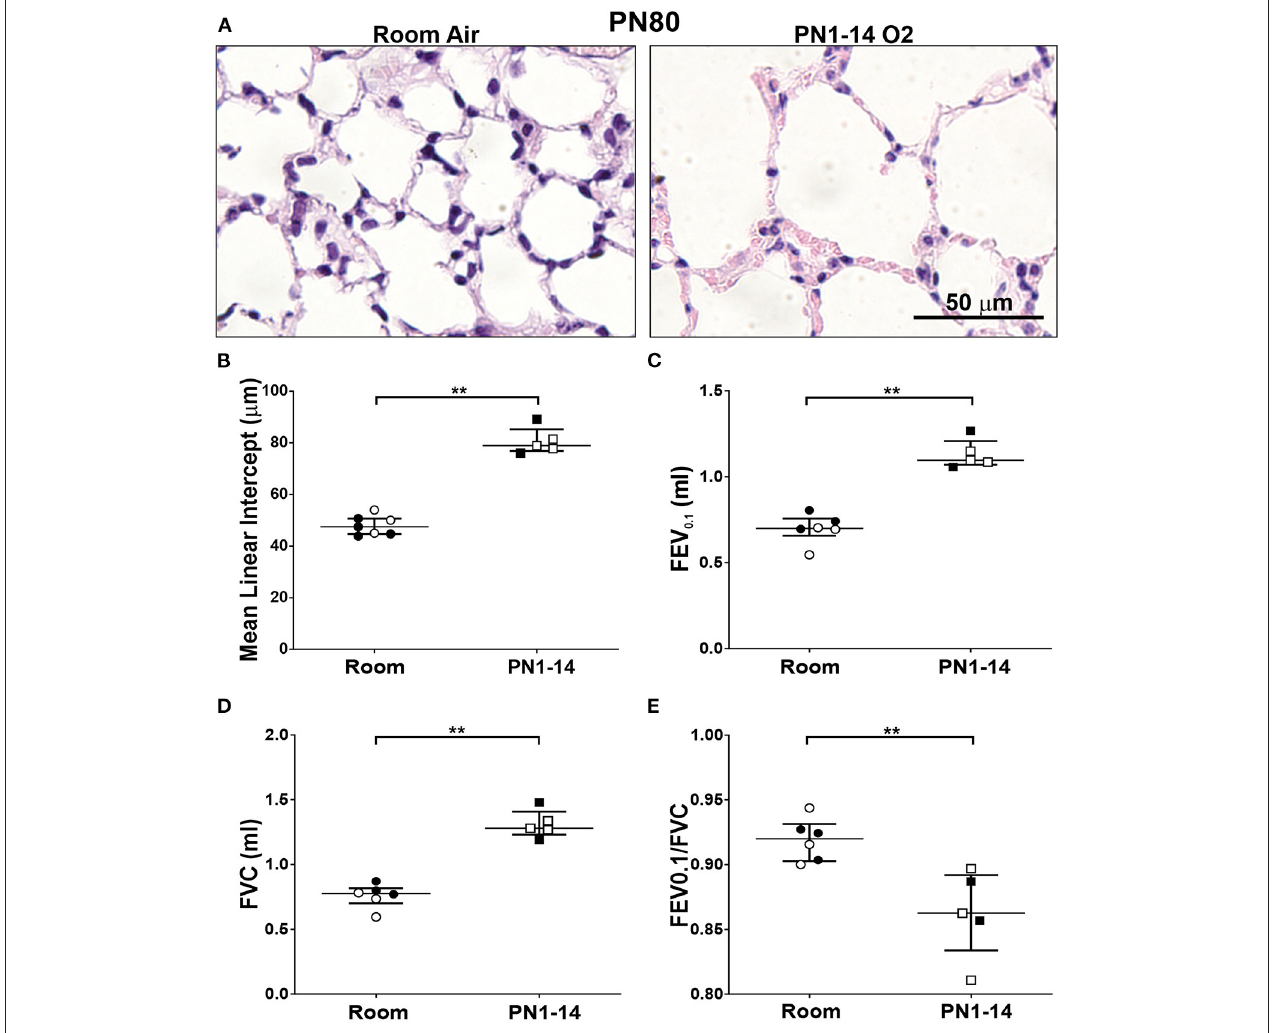
FIGURE 6 | Decline in lung function in mature adult mice exposed to prolonged supplemental oxygen in infancy. (A) Representative photomicrographs of H&E-stained lung cross-sections at PN80 comparing C57BL/6 room air control mice and PN1-14 oxygen-exposed mice. Images were taken with a 40x objective using an Olympus BX-51 bright field microscope. Scale bar = 50 µ m. (B) Quantitation of airspace diameter (MLI) of lung sections shown in (A) . Assessment of (C) FEV0.1, (D) FVC, and (E) FEV0.1/FVC ratio by negative pressure-driven forced expiration using the Flexivent. All data are presented as median ± IQR and assessed using Mann-Whitney U -test (2-tailed); ** P < 0.01. n = 5–6 mice per group from 1 litter. Gender is represented by closed (male) and open symbols (female). PN, postnatal.